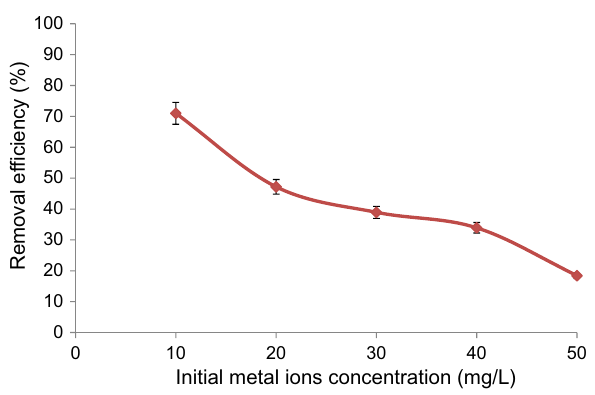
Fig. 4 Effect of temperature on the adsorption of Cd(II) ion onto UMSFS